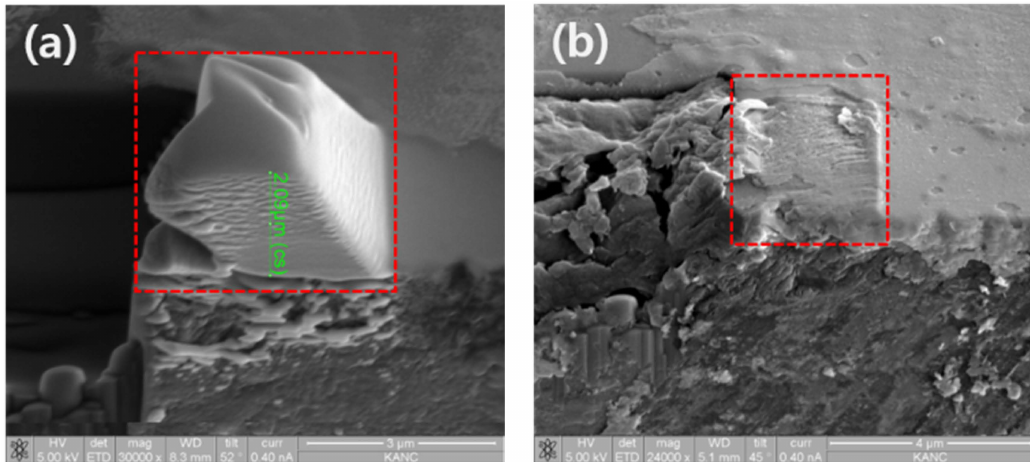
Figure 7. SEM images of ( a ) 2.09 µ m Pt coating; ( b ) after etching with aqua regia for 8 h.